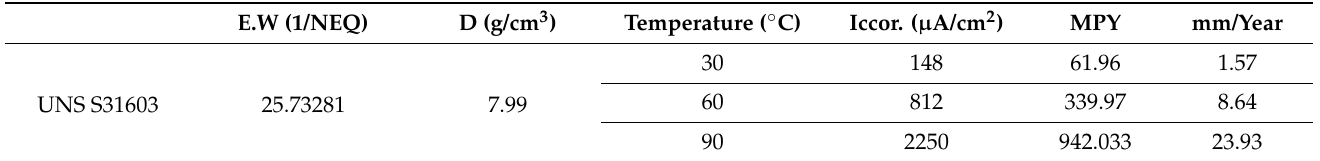
Table 3. Alpha( α ) value calculation process after the electrochemical experiments on UNS S31603 and UNS N08367 in a modified green death solution with